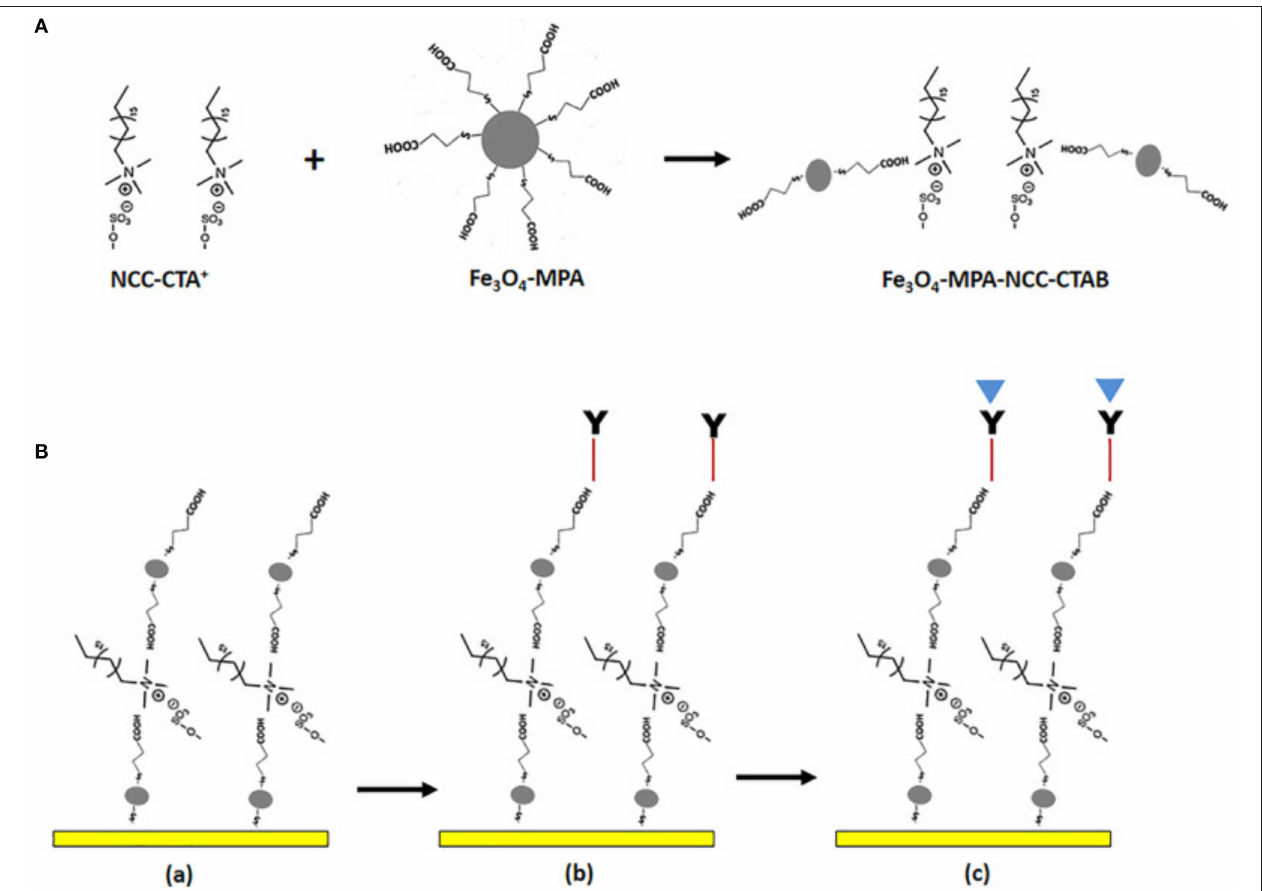
FIGURE 4 | (A) Illustration of possible mechanism for the preparation of Fe-MPA-NCC-CTAB composite aiming the dengue virus recognition (B) The sensor functionalization. (a) Surface activation of gold/Fe-MPA-NCC-CTAB layer, (b) Immobilize the IgM antibody via EDC-NHS cross-linker, (d) Injection of dengue E-protein solution. Reprinted with permission from Omar et al. (2018). Development of an optical sensor based on surface plasmon resonance phenomenon for diagnosis of dengue virus E-protein, Sensing and Bio-Sensing Research 20,